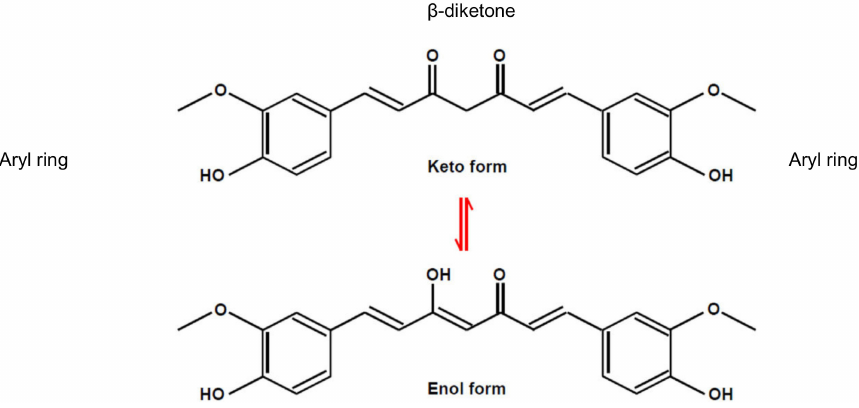
Figure 1. Chemical structure of curcumin